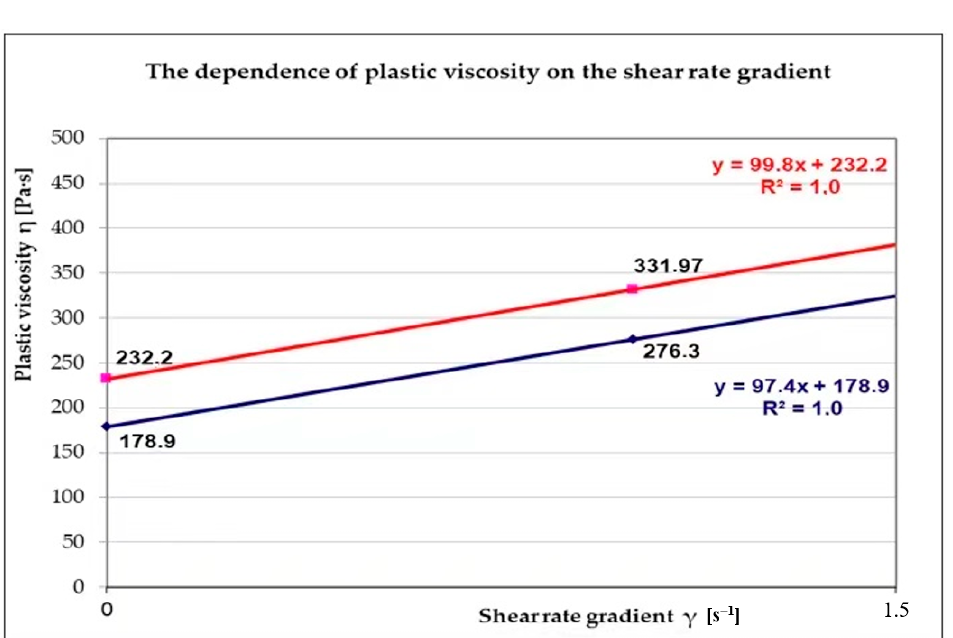
Figure 9. The dependence of plastic viscosity on the gradient of the shear rate of the concrete mix with the SCC 4 ‐ G and SCC 11 ‐ B recipe composition.